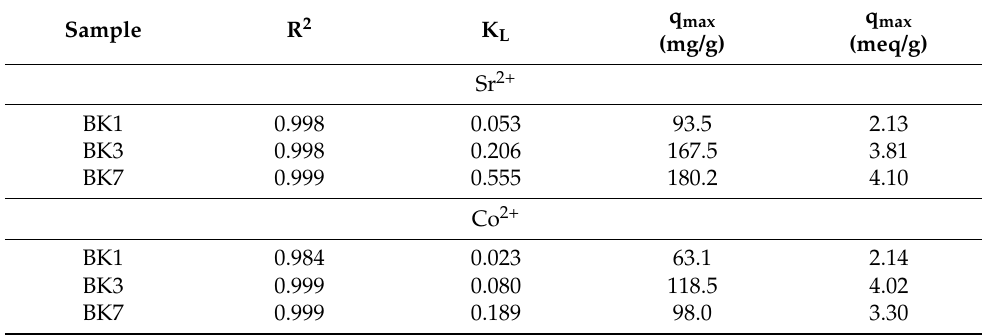
Figure 4. ( a , b ) Adsorption isotherms and ( c , d ) Langmuir plot of metakaolin and alkali-activated samples for Sr 2+ and Co 2+ . Table 2. Adsorption parameters of BK samples from the Langmuir isotherm model.